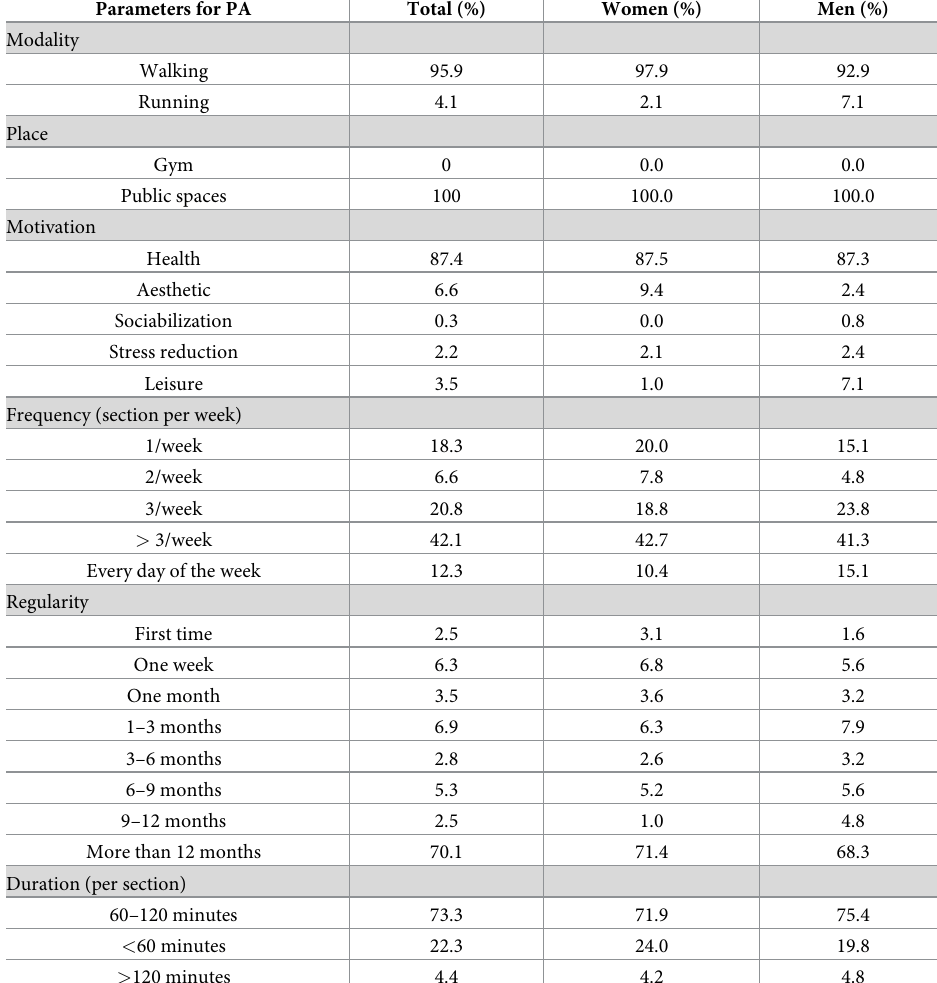
Table 3. Life habits and physical activity (PA) routine. Sample stratified by age and gender: women (N = 192) and men (N = 126). Parameters for PA